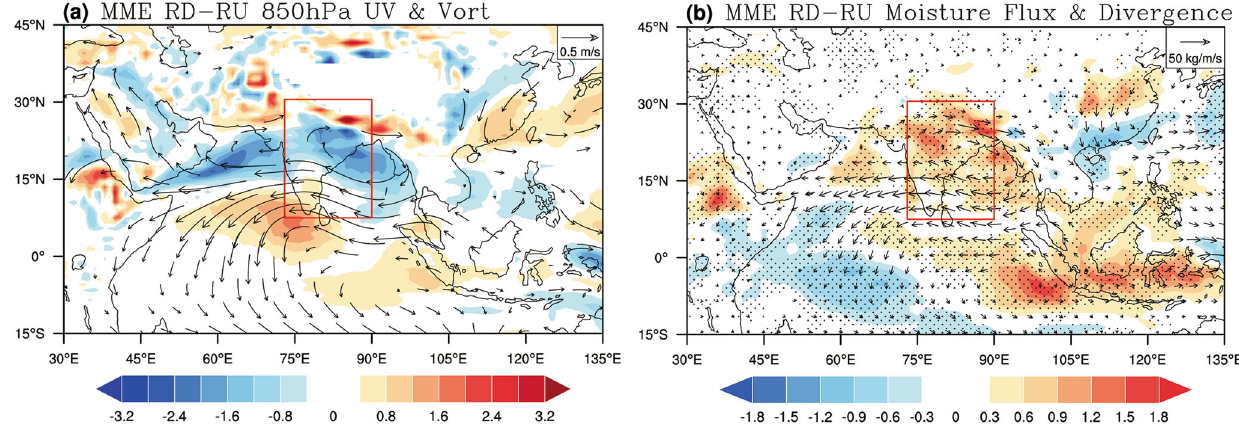
Fig. 6 The response of the low-level circulation and the moisture transport. a The difference in the pattern of the 850 hPa wind (vectors; unit: m s − 1 ) and vorticity (shadings; unit: 10 − 6 s − 1 ) between the RU and RD periods. b The same as in ( a ), but for vertically integrated moisture fl uxes from the surface to 1 hPa (vectors; unit: 10 2 kg m − 1 s − 1 ) and their divergence (shadings; unit: 10 − 5 kg m − 2 s − 1 ). The black dots denote the region in which at least 70% of models agree on the sign of the MME. Vectors only exceeding 70% of model consistency are shown. The red rectangles highlight the SASM